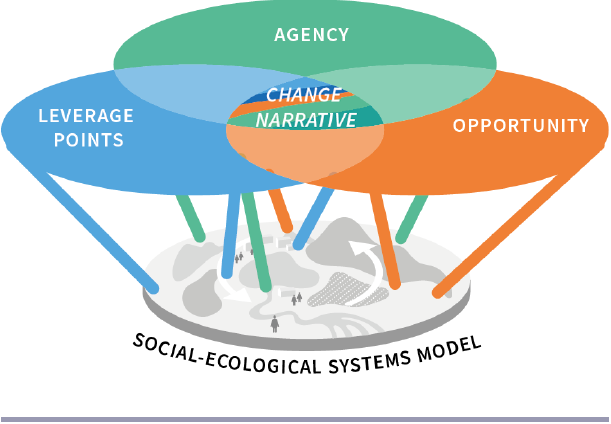
Fig. 4. Innovative strategies for change are designed using a triple-focus lens. Wayfinder’s approach to designing change strategies draws on users’ understanding of systems dynamics and looks at these dynamics to identify leverage points for systemic change, actors with capacity to influence those points, and the overall opportunity context for realizing change in the system. Illustration: E.